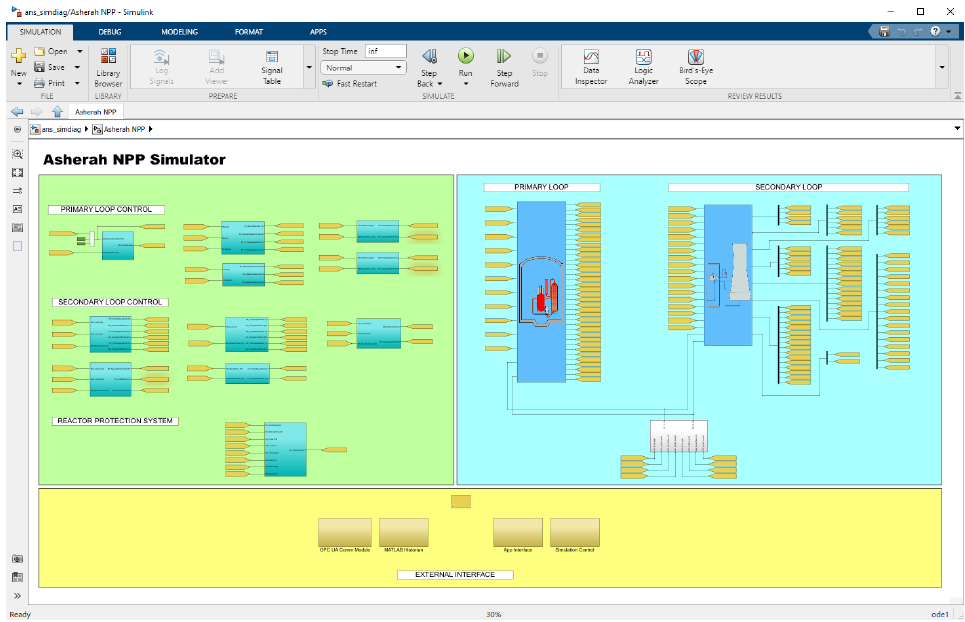
Figure 5. General View of the ANS